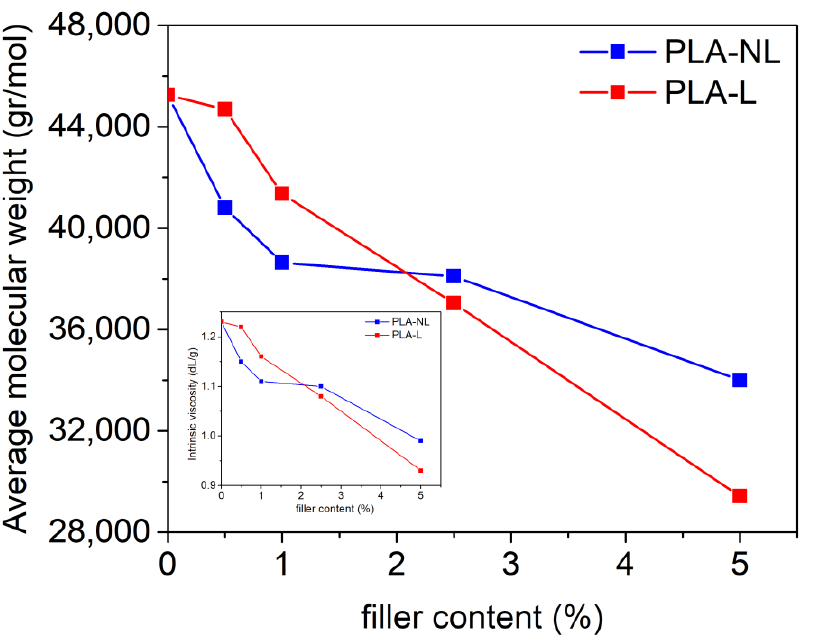
Figure 1. M n and intrinsic viscosity (inset) of PLA–L (red) and PLA–NL (blue) composites with Figure 1. 𝑀 𝑛̅ and intrinsic viscosity (inset) of PLA – L (red) and PLA – NL (blue) composites with different filler contents. different filler contents.